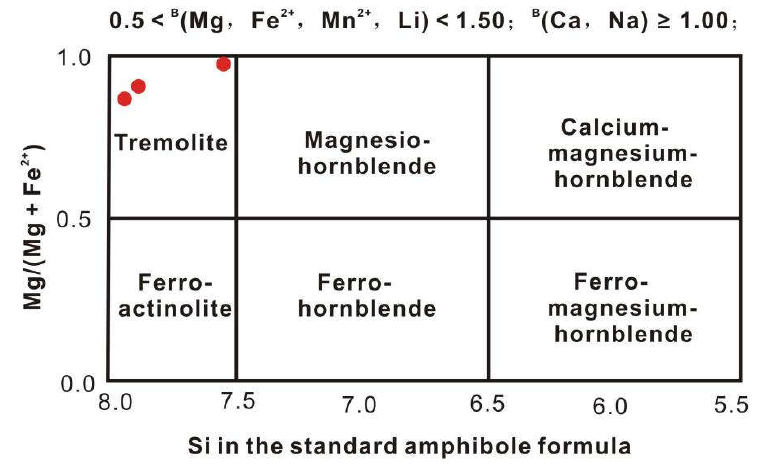
Figure 6. Diagram for classification and nomenclature of amphibole series with Ca.